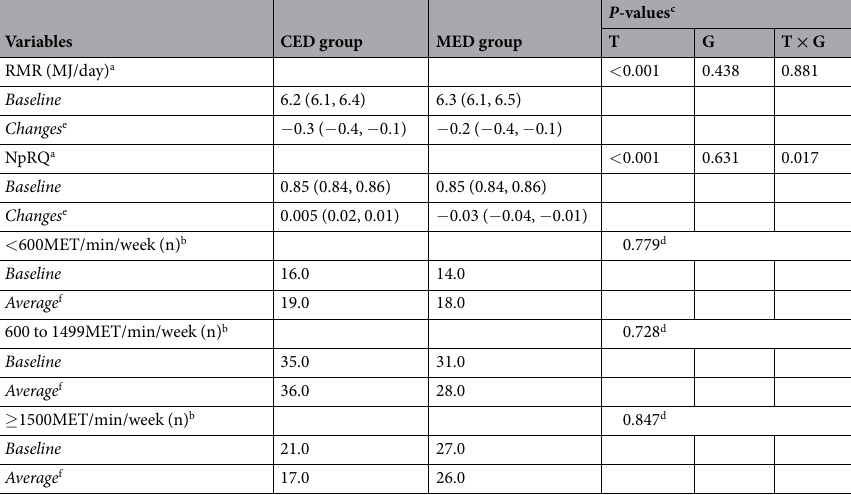
Table 4. PA and metabolic measurements in the CED and MED groups. Abbreviations: a Continuous values are expressed as means (95% CI) and b categorical values as number of subjects; RMR: resting metabolic rate; npRQ: nonprotein respiratory quotient; c Linear mixed model for values at each time point, significant at P < 0.05; d difference between number of subjects in the compared groups (Chi-square test of independence); CED: baseline: n = 72; week 4: n = 70; week 8: 68; week 12: n = 65; week 16: n = 63; MED: baseline: n = 72; week 4: n = 72; week 8: 72; week 12: n = 70; week 16: n = 67; values at baseline and e changes from baseline to follow-up, as well as the f average number of subjects in each PA category averaged across the four postrandomization time points are presented.